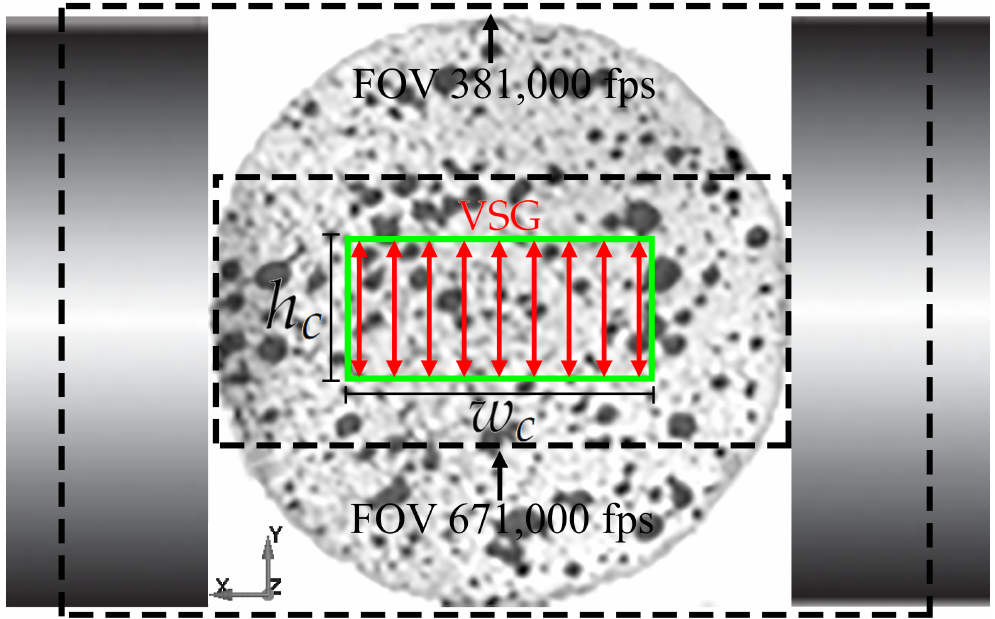
Figure 5. An example of a speckle on the dynamic Brazilian disc tests, the two Field of Views (FOV) used for the high-speed photography and the RSR (green